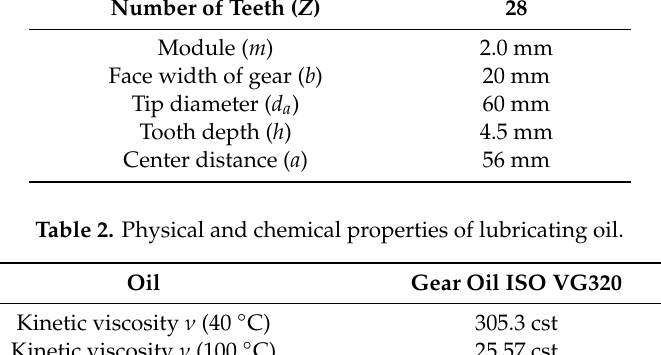
Figure 1. Schematic of the simulation model and the definition of β . Table 1. Geometrical parameters of gears.